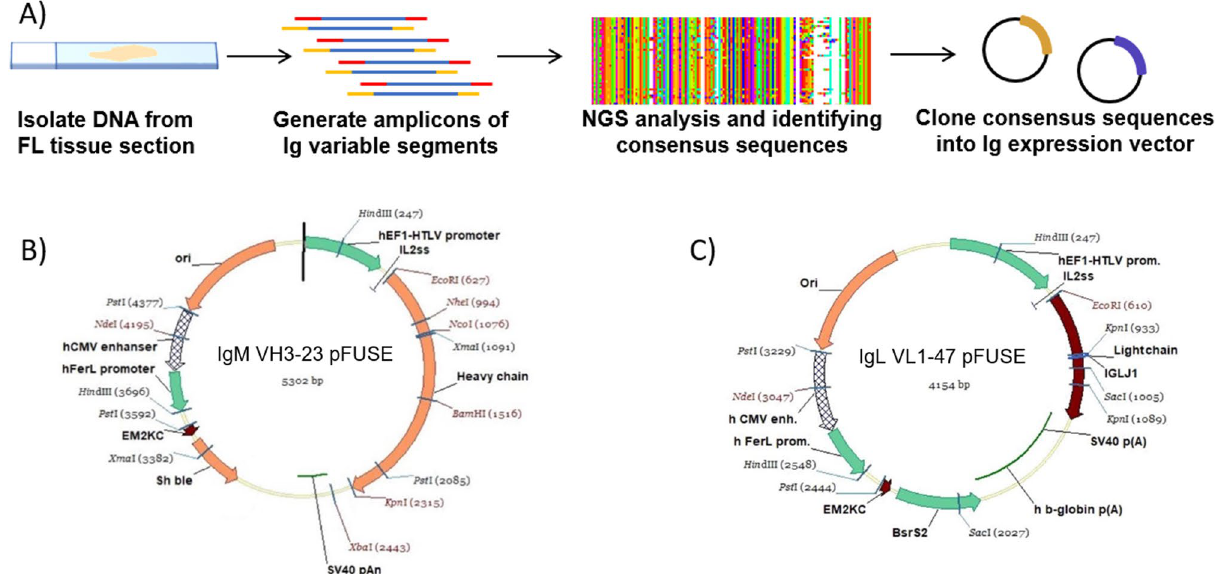
lymphoma B cell tissue sections. ( B ) Plasmid map of IgM VH3-23 pFUSE vector and ( C ) IgL VL1-47 pFUSE vector used for production of surface antibody displaying the variable heavy and light chain consensus segments identified from FL B cell sections and carrying genes for zeocin and blasticidin resistance, respectively. Plasmid maps made using VectorNTI version 10.3.0 (Thermo Fisher Scientific, USA, https:// www. therm ofish er.